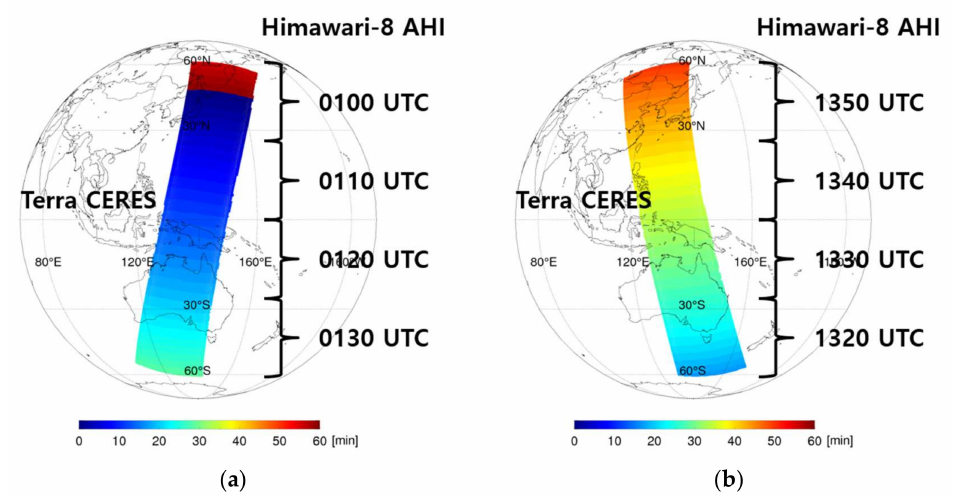
Figure 1. Daytime ( a ) and nighttime ( b ) examples of observation area according to observation time of Terra CERES (color bar) and Himawari-8 AHI.